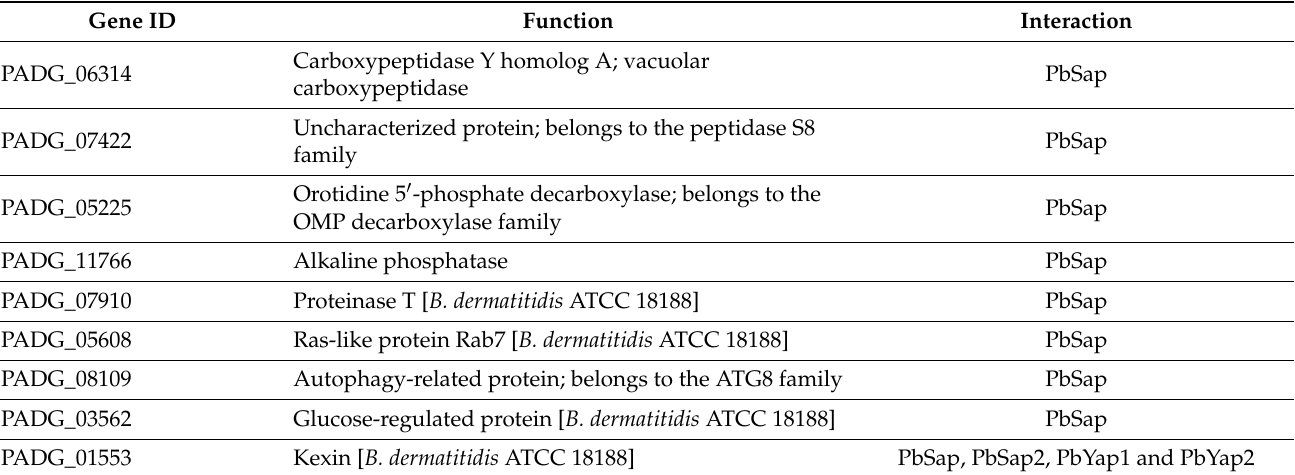
Table 4. Predicted functional partners of the aspartic proteases of P. brasiliensis detected using string network